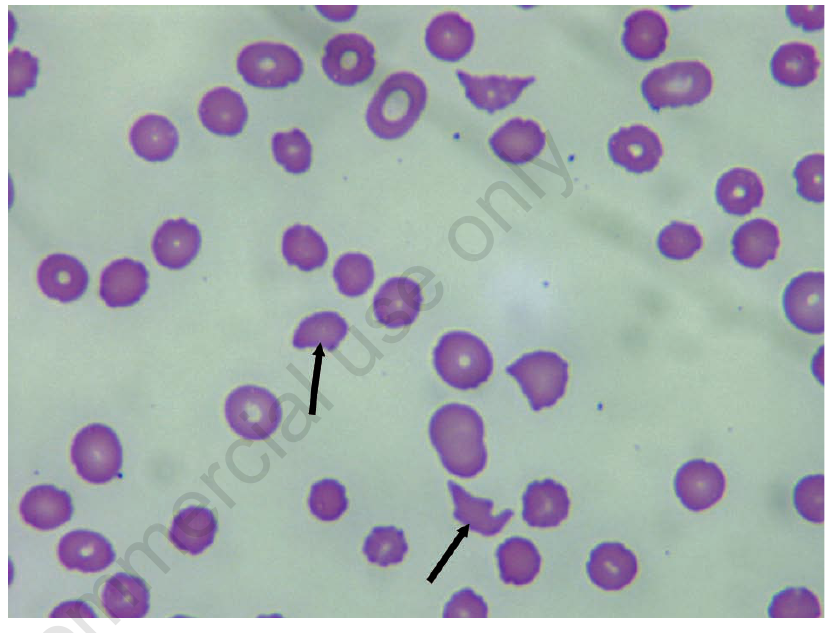
Figure 1. Peripheral smear showing plenty of schistocytes (indicated by arrow), polychro- masia and markedly decreased platelets.